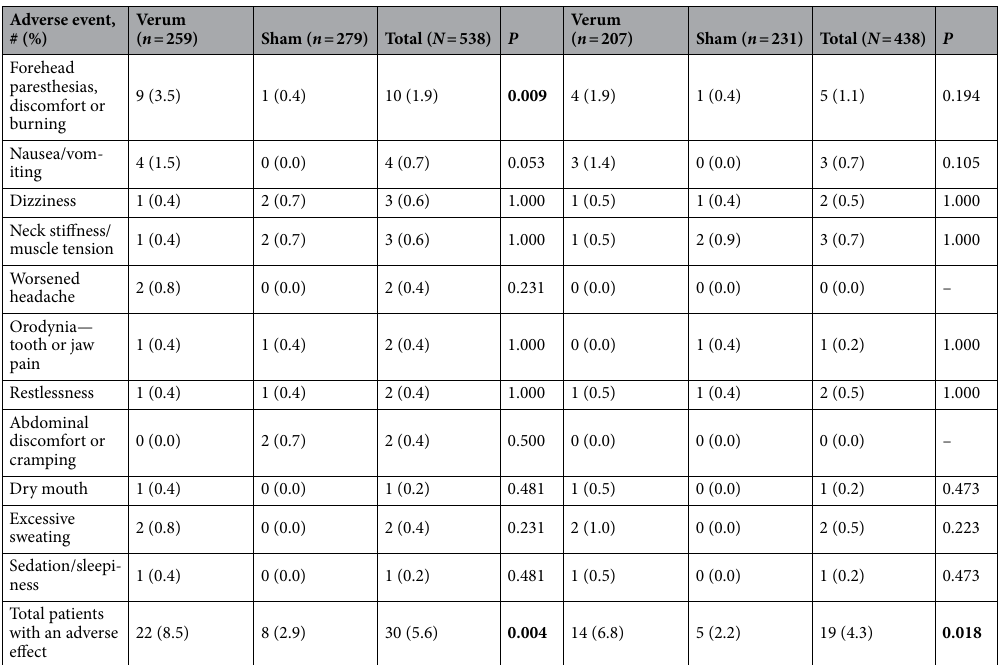
Table 4. Adverse events. Fisher’s exact test is used for all comparisons due to cell counts < 5, and therefore X 2 statistic is not presented. ‘Total patients with an adverse effect’ does not add up to the total number of adverse effects in separate categories due to one patient in each group having two adverse